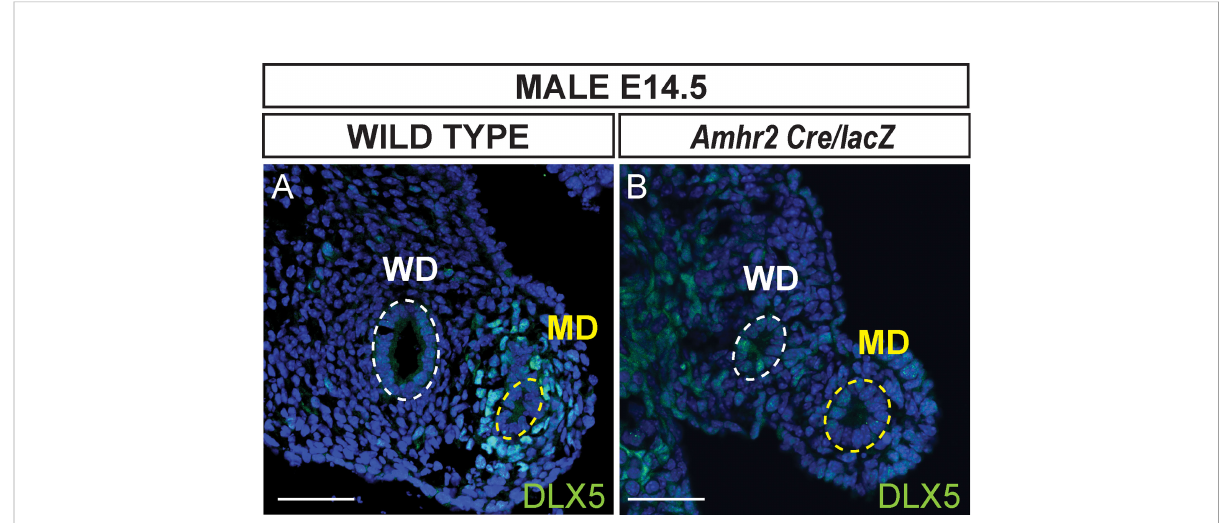
FIGURE 3 AMH signaling is required for DLX5 expression. Immuno fl uorescent staining of DLX5 in cross sections of the mesonephros from E14.5 wild-type (A) and Dlx5-lacZ/+ ; Amhr2-Cre/lacZ (B) male embryos. DLX5 is not expressed in Amhr2-Cre/lacZ males, indicating AMH signaling is required for DLX5 expression in the male Müllerian duct (MD). Yellow dotted lines surround the MD epithelium; white dotted lines surround the Wolf fi an duct epithelium (WD). MD, Müllerian duct; WD, Wolf fi an duct. Scale bars = 50 µm. Each genotype analyzed n=3.